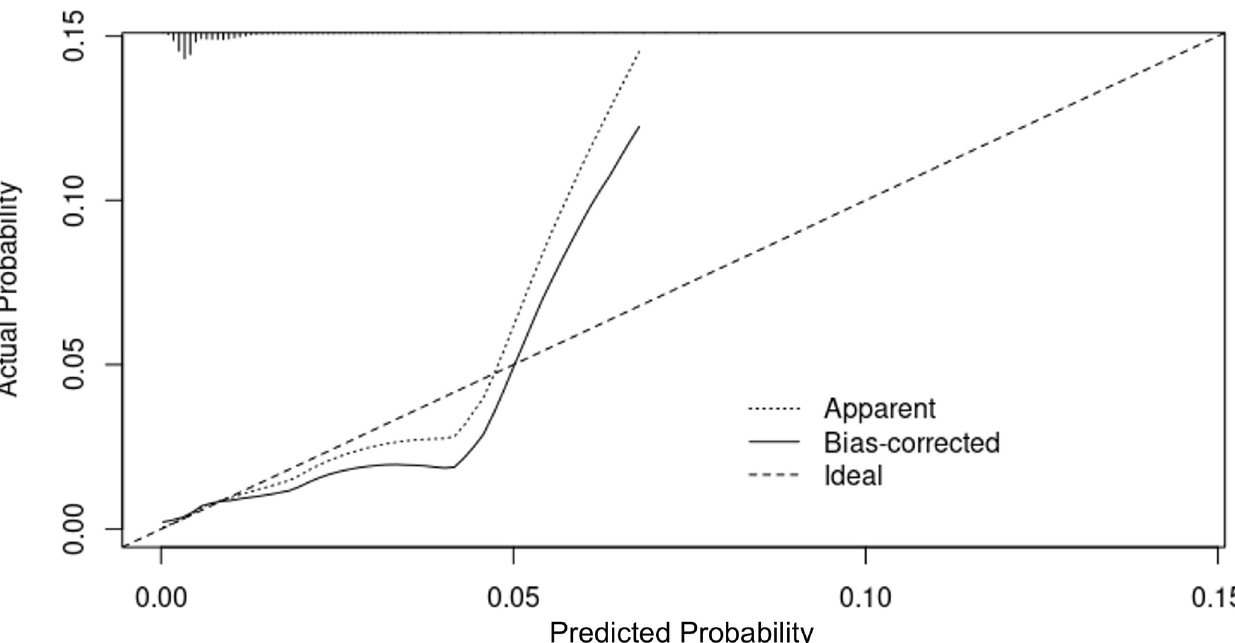
Fig 3. The calibration curve for the Model I (logistic regression model). On the x-axis are the predicted probabilities and on the y-axis the observed probabilities. A perfectly calibrated model would follow the straight dashed line referred as “ideal” in the picture. On average, the Model I overestimated the probability of revision for dislocation in patients that had low probability of this outcome, and underestimated the probability of revision for dislocation in patients that had the highest probability of this outcome.